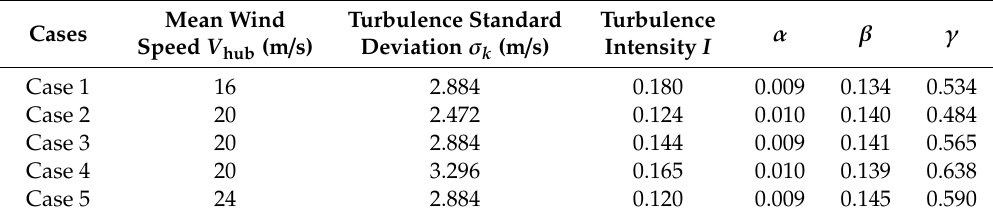
Table 5. Parameters for the second-order filter for di ff erent wind conditions with di ff erent horizontal mean wind speeds and turbulence standard deviation.